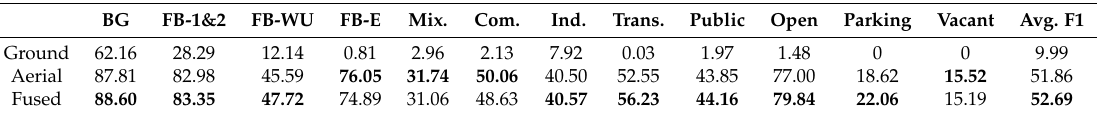
Table 4. Per-class results on Queens test set (%).